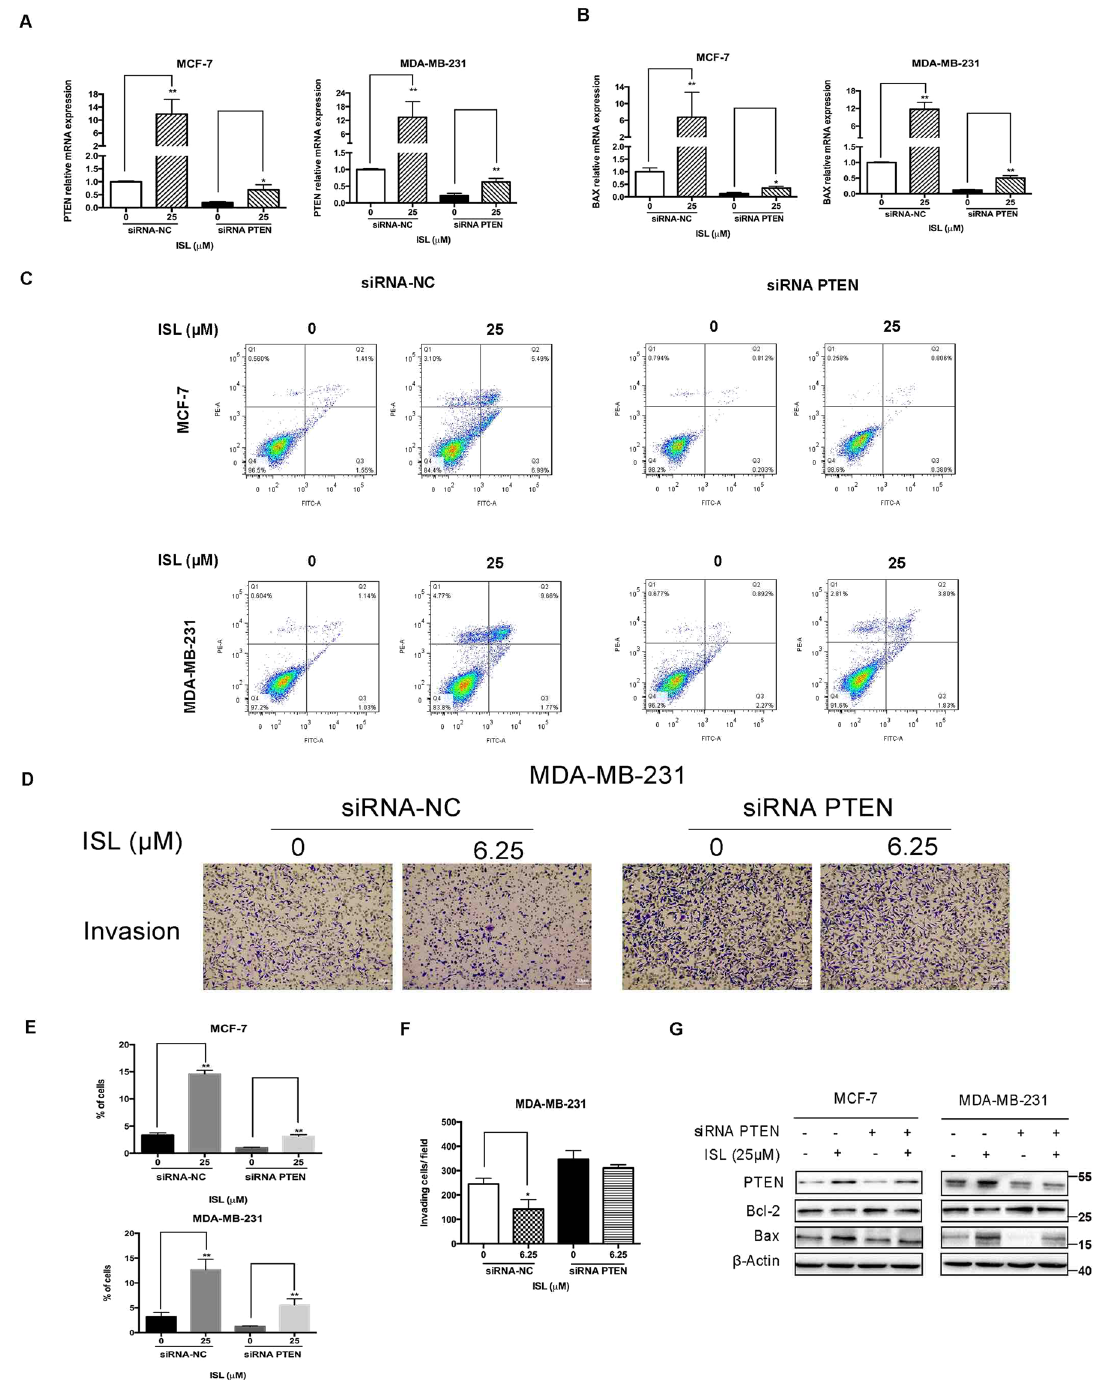
Figure 7. Deletion of PTEN expression restricts the anti-cancer effect of ISL on breast cancer cells. ( A ) qRT- PCR analysis of PTEN mRNA expression in siRNA-NC and siRNA PTEN transfection groups after 24 h ISL treatment. ( B ) qRT-PCR analysis of BAX mRNA expression in siRNA-NC and siRNA PTEN transfection groups with ISL interference. ( C ) Representative images of induction of apoptosis in breast cancer cells determined by Flow cytometry analysis after 24 h ISL intervention. ( D ) Chamber invasion assay analysis of the effect of siRNA PTEN transfection on breast cancer motile ability with ISL treatment for 24 h. ( E ) Percentages of apoptotic cells after ISL treatment with siRNA PTEN intervention. ( F ) Percentages of the number of cells invading in the ISL treatment with siRNA PTEN interference. ( G ) Western blot analysis of PTEN function on Bcl-2 down-regulation and Bax up-regulation by ISL. The full-length blots were presented in the Supplementary Fig. 10. Data represent the mean ± s.d. * P < 0.05, ** P <